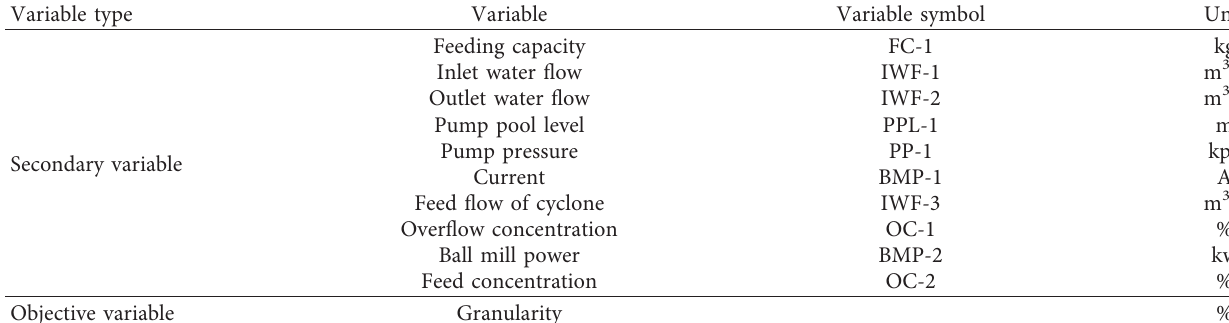
Table 2: Information on various variables of the grinding process.